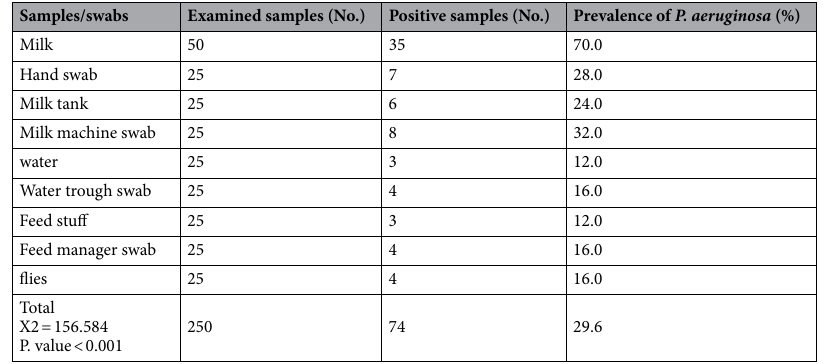
Table 2. Prevalence of P. aeruginosa recovered from animals, their environment, and humans during the study period.